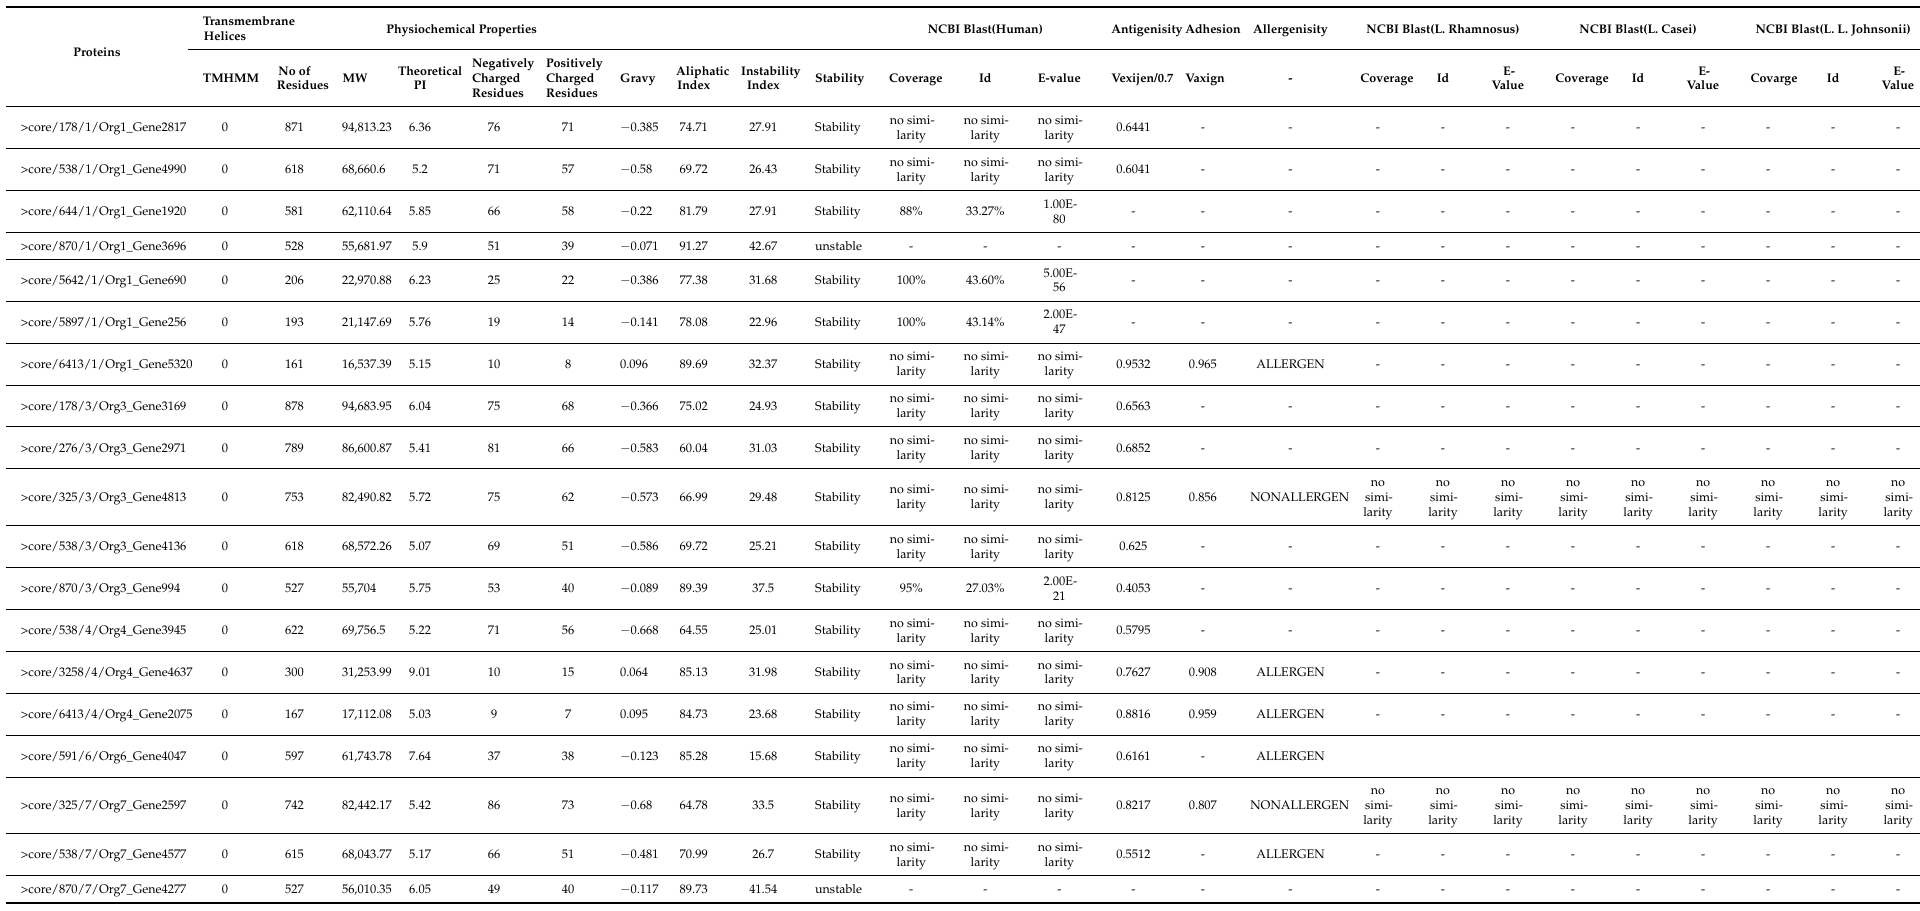
Table 1. Different set of parameters used to prioritize potential vaccine candidates. In the table, only virulent proteins are shown along with the value for all the vaccine